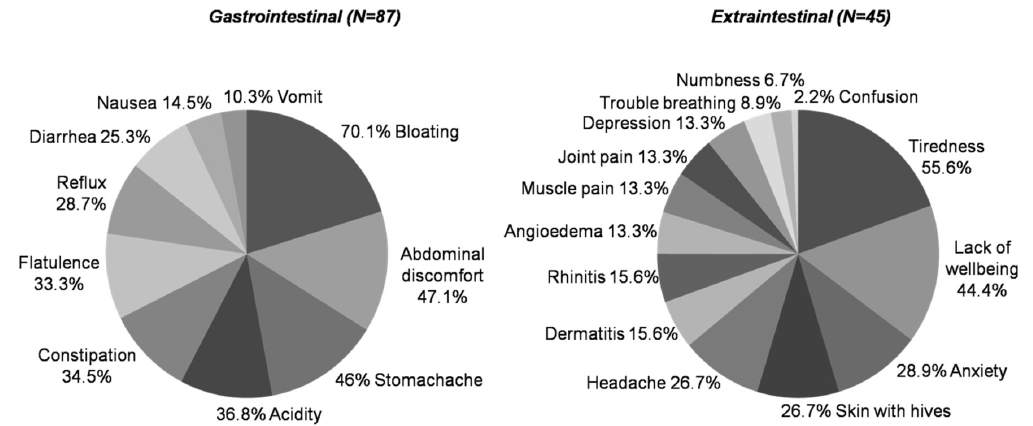
Figure 3. Recurrent self ‐ reported symptoms in SR ‐ GS cases.